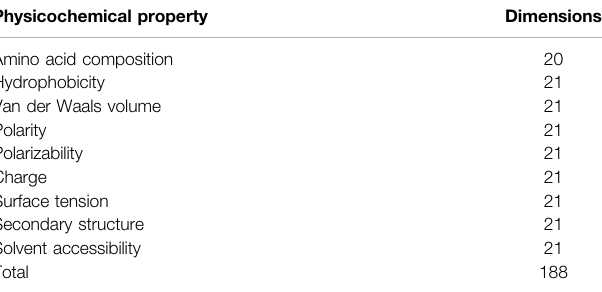
TABLE 3 | Ingredients contained in the 188-dimensional feature of a protein. Physicochemical property